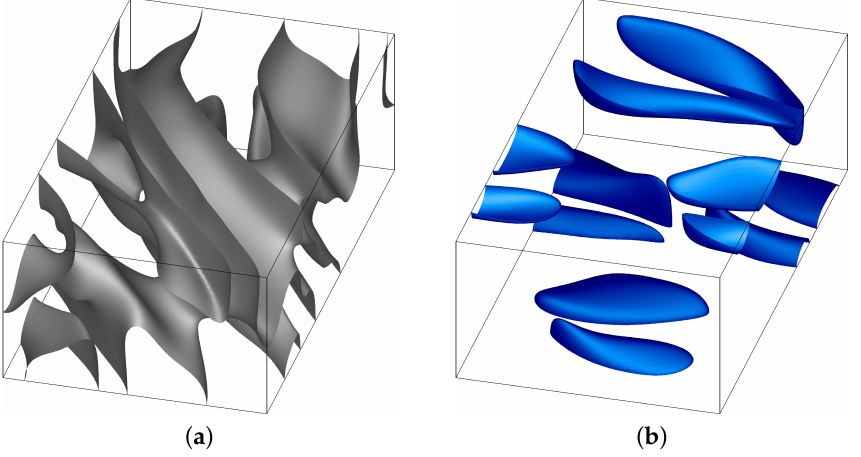
Figure 6. Isosurfaces of the kinetic (a) and magnetic (b) energy densities at the level of 1/2 of their respective maxima in run 1 x 2.3 at time t = 1650.707. One double-period fluid box is